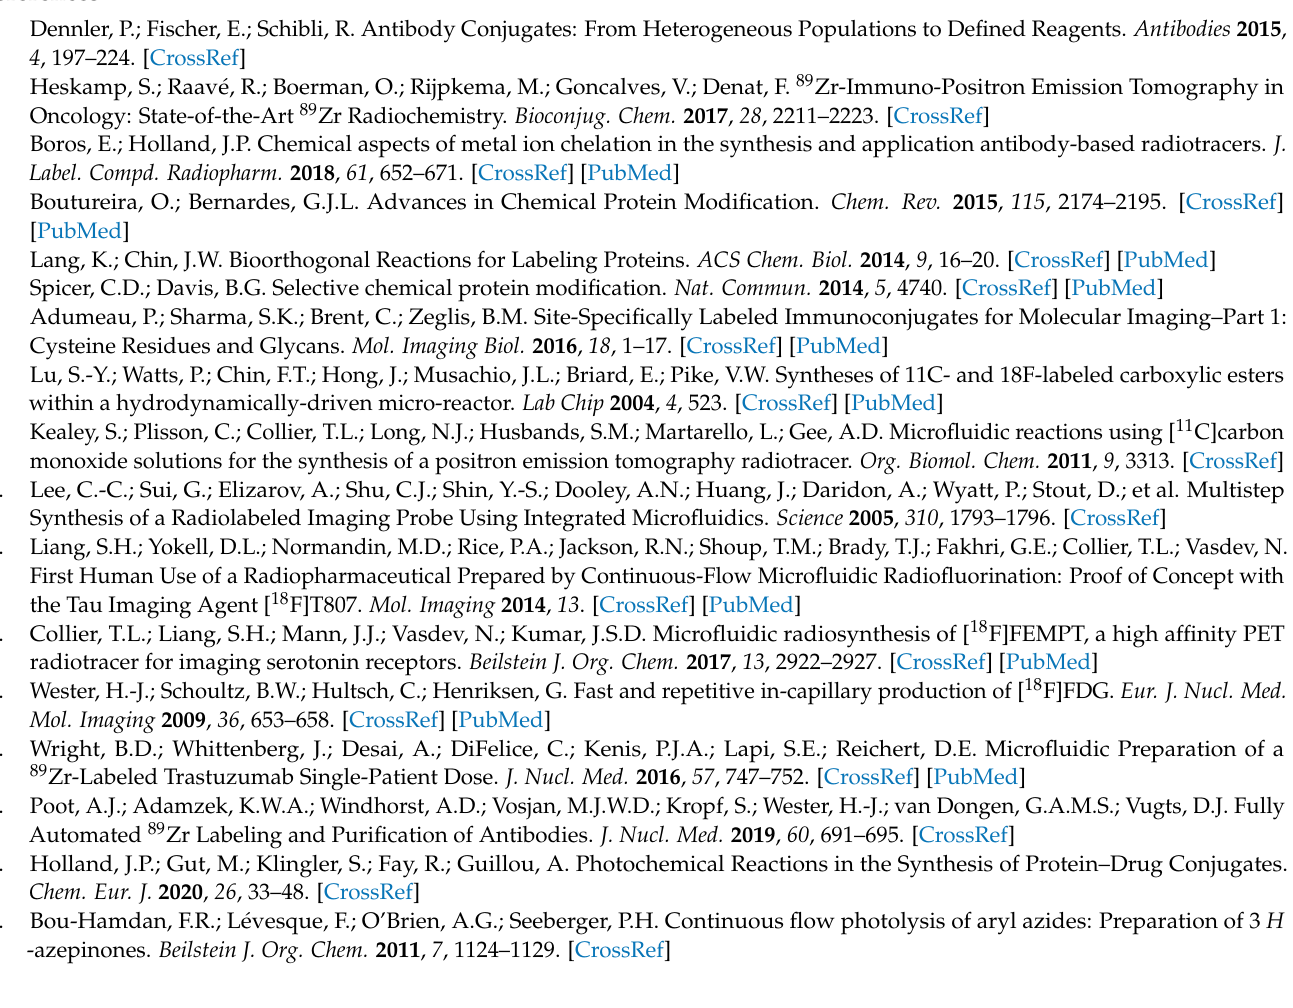
Figure S17. HRMS spectrum of compound 1 . Figure S18. Characterisation data for the